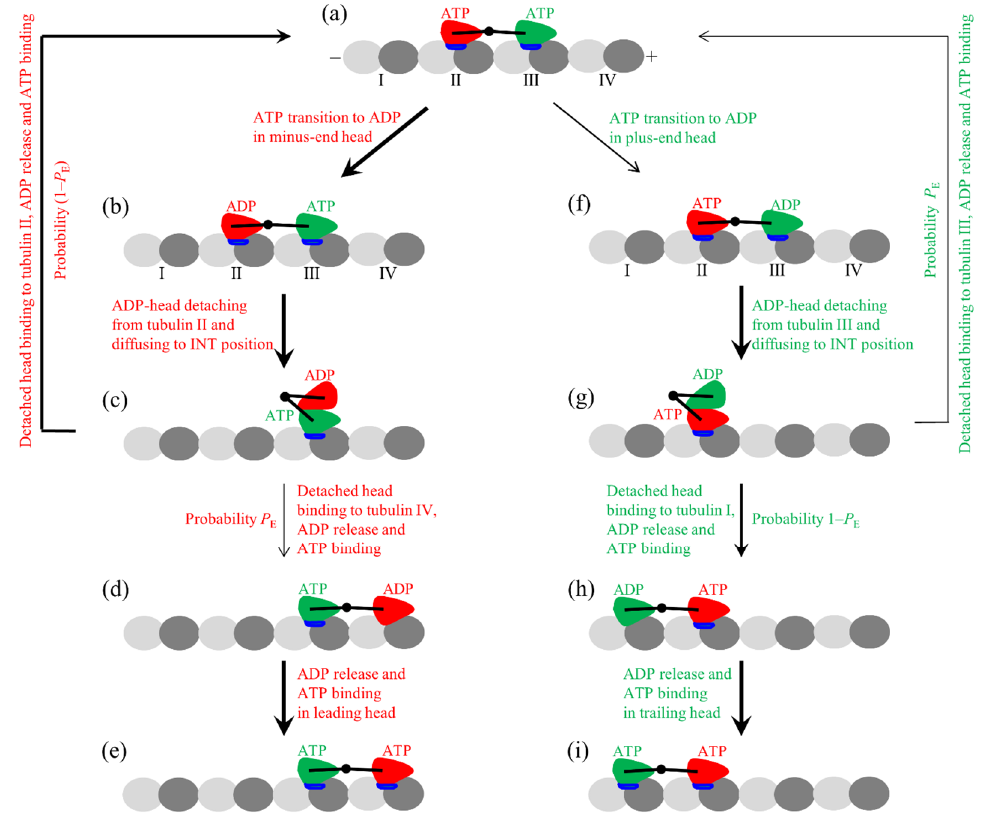
Figure 6. Schematic illustrations of the chemomechanical coupling for NcdKHC, the engineered motor consisting of the Ncd stalk and neck joined to the KHC motor domain. ( a )–( i ) The pathway at saturating ATP concentrations. At saturating ATP, the nucleotide-free state of the kinesin head is so short that is not needed to be considered. Since in both the ATP and ADP.Pi states the kinesin head has a similar conformation and has a high affinity to the MT, for simplicity, ATP hydrolysis and Pi release are treated as one step in the ATP transition to ADP. The thickness of an arrow indicates the relative magnitude of the probability of transition between two states connected by the arrow under no load.